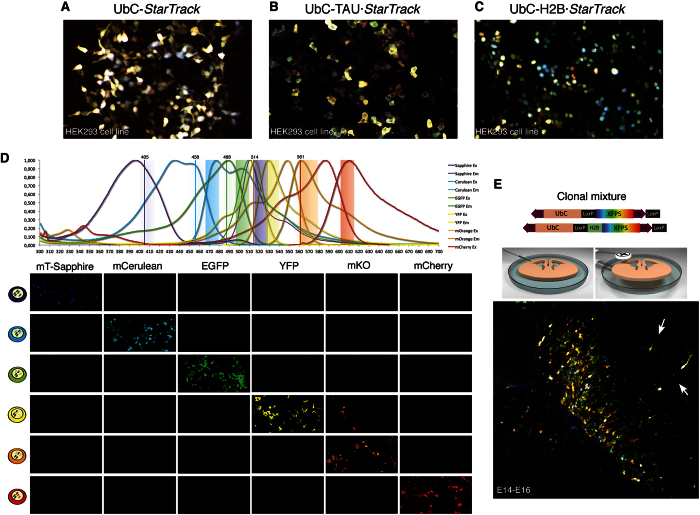
In vitro and ex vivo transfection of the UbC-StarTrack variants.(A–C) Newly generated UbC-StarTrack (A), UbC-TAU·StarTrack (B) and UbC-H2B·StarTrack (C) constructs were transfected to HEK cells in vitro and fluorescent signals were acquired 1 day after transfection. (D) Fluorescent spectra of the different fluorescent reporters under the specific confocal acquisition settings. Each fluorescent protein was electroporated individually and its expression was recorded in all confocal channels. Fluorescent expression was only acquired in the designated channel, except for YFP that displayed weak fluorescence in the mKO confocal channel. (E) UbC-StarTrack and UbC-H2B·StarTrack were suitable to perform ex vivo clonal analyses after electroporation of the ubiquitous mixture into E14 brain slices since labeled cells migrated out of the area electroporated after 2 days in culture (arrows). 3D-draw provided by Lluis Fortes-Marco.